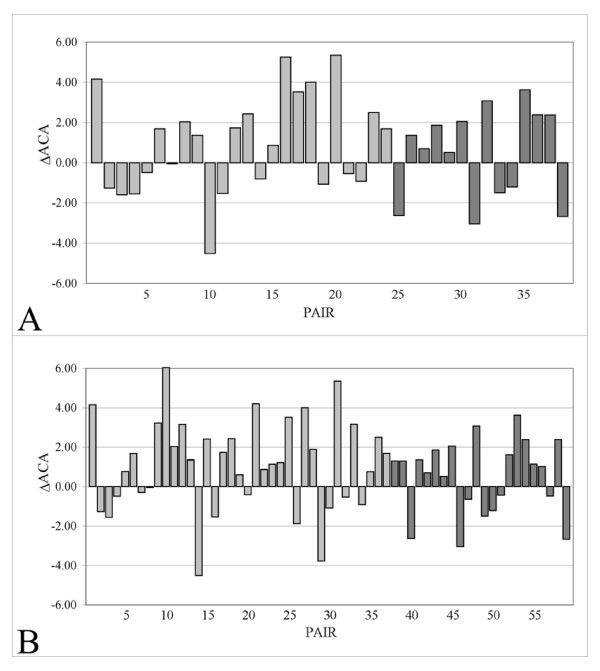
Differences in the apolar contact area (ΔACA) for each protein pair, composing dataset A and B, computed over the whole protein structure. Values for hyperthermophilic/mesophilic protein pairs and thermophilic/mesophilic pairs are expressed in Å2/residue and represented as light grey and dark grey bars, respectively. Numbers on X-axis refer to Table 1 (A) and Table 2 (B).